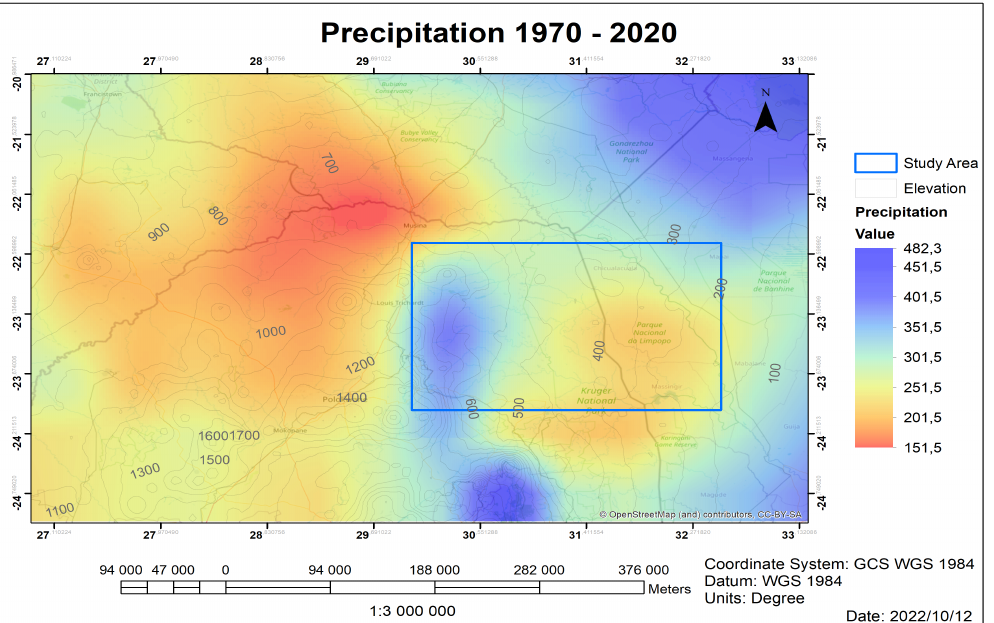
Figure 2. Map showing the annual average precipitation of the study area in the Lowveld region of Limpopo. Source: Authors’ creation.